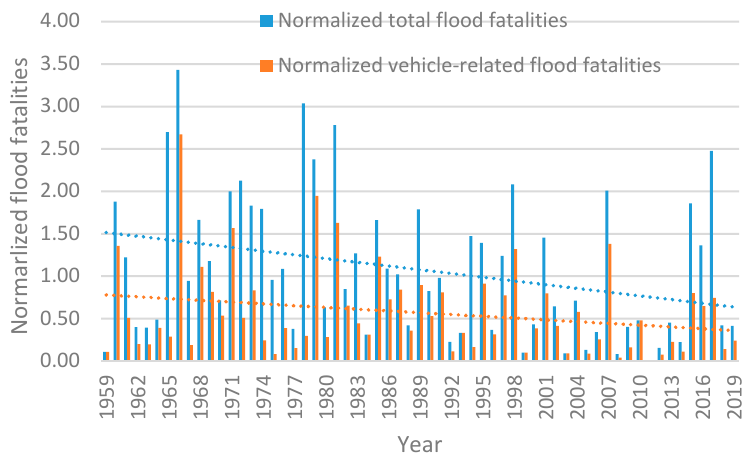
Figure 3. Normalized numbers of total flood fatalities and vehicle-related flood fatalities per 1 million people in Texas, 1959–2019.